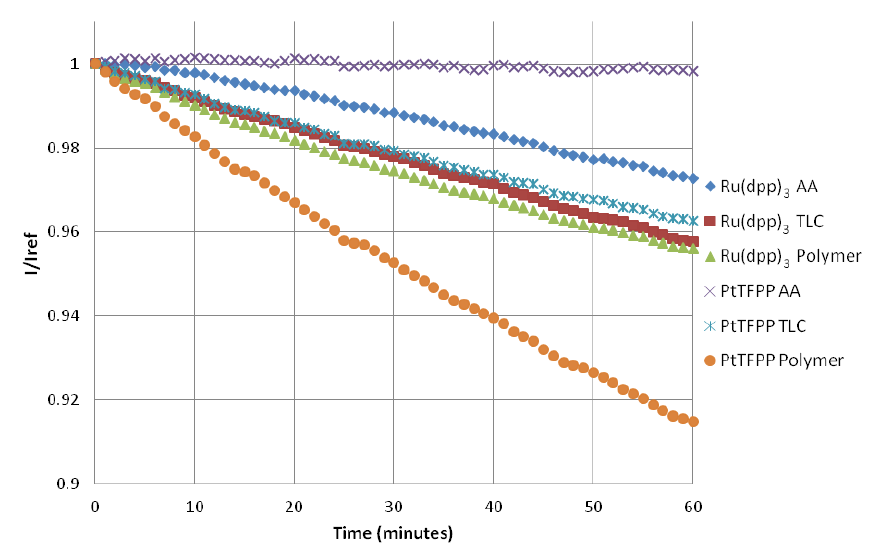
Figure 10. Photodegradation of PSP